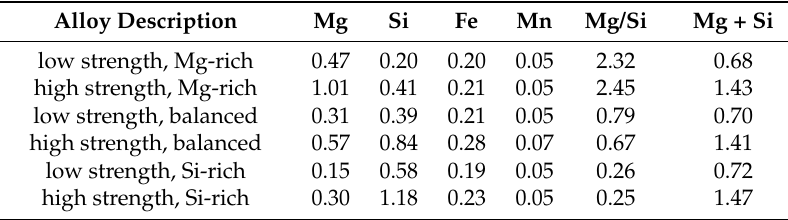
Table 1. Experimental alloy compositions.